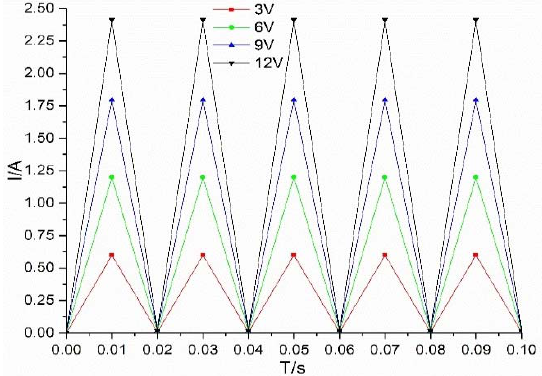
Figure 11. Current curves under different voltages.